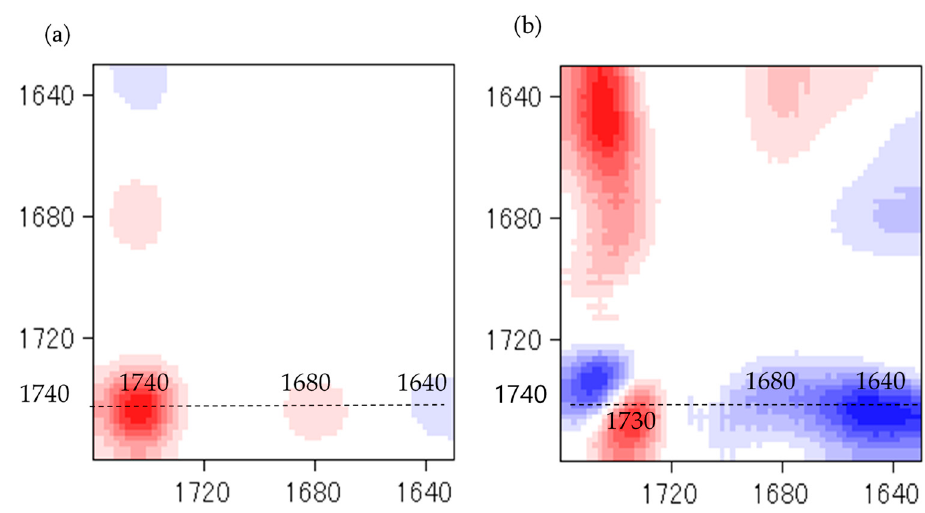
Figure 3. Synchronous ( a ) and asynchronous ( b ) spectra at different heating temperatures in carbonyl region.